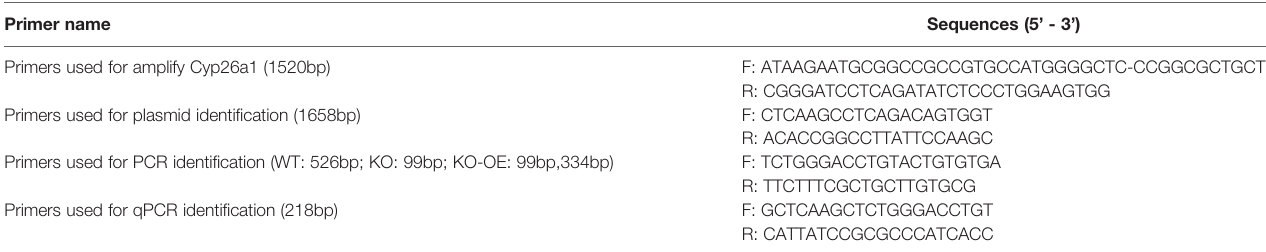
TABLE 2 | Primers used for lentivirus-mediated CYP26A1 overexpression in